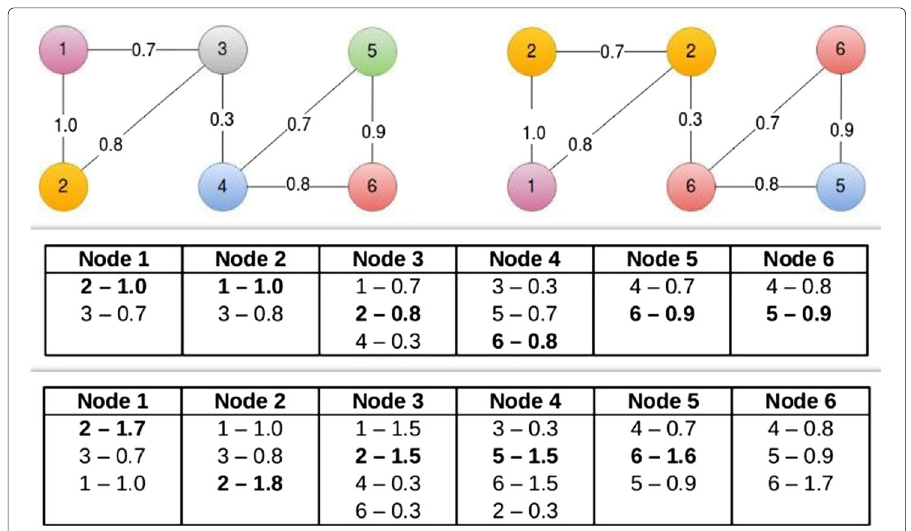
Fig. 1 Iterations of MemLPA on a weighted undirected graph. Color and node number represent labels. Columns in the table represents nodes memory. In the first iteration, node 1 receives labels 2 and 3 from its neighbors. Using the classical LPA, in the second iteration, it would discard these labels and collect new ones (label 1 and 2). With memory, instead, the old labels are not discarded but updated, therefore node 1 contains labels 1, 2 and